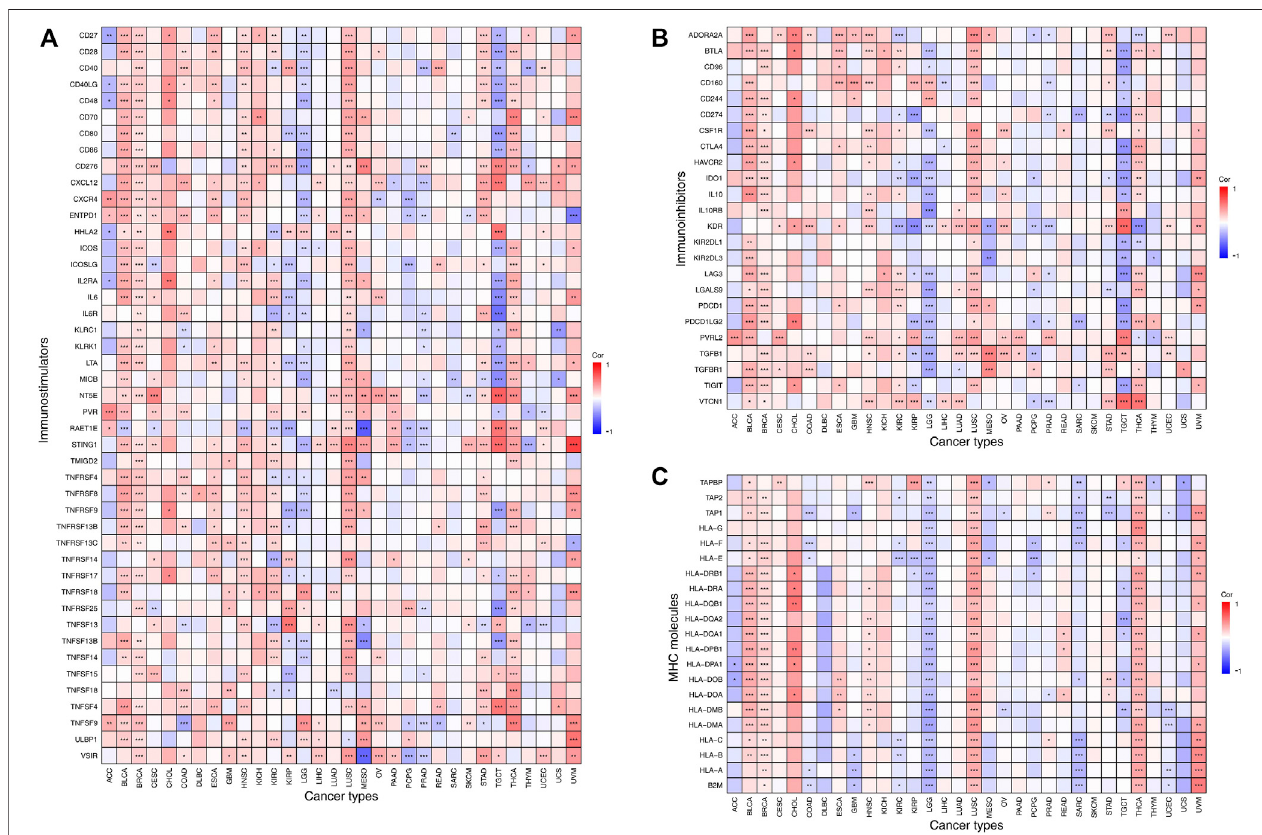
FIGURE 7 | Association between expression levels of VSTM2L and immune checkpoint markers in TIMER, which includes immune checkpoint genes from the TISIDB database. Association between the expression of VSTM2L and immunostimulatory factors (A) and immunoinhibitory factors (B) and MHC molecules (C) . * P adjusted < .05, ** P adjusted < .01, *** P adjusted <